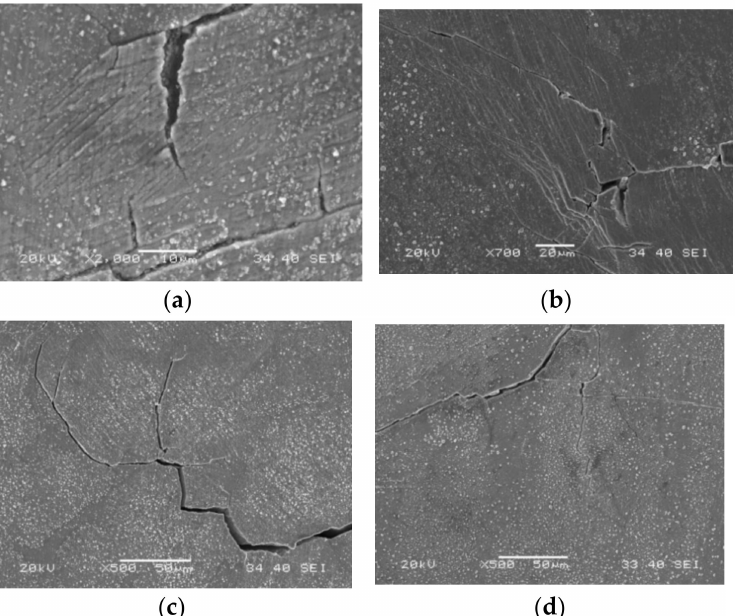
Figure 8. Crack tip morphology of the LCF specimens at the strain amplitude of 0.8% and the strain rate of 0.4%/s in high temperature water: ( a ) crack coalescing; ( b ) crack crossing; ( c , d ) crack bifurcating.